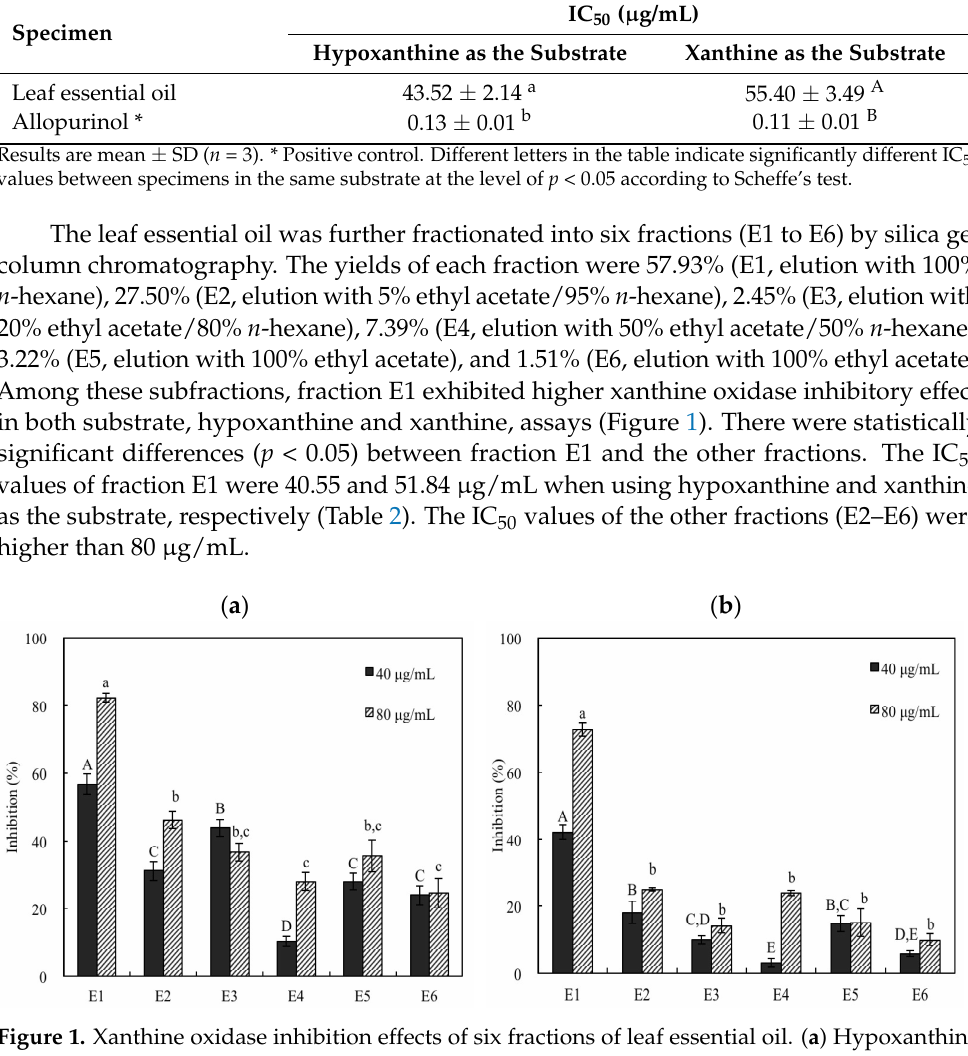
Table 1. IC 50 values of Pistacia chinensis leaf essential oil against xanthine oxidase.